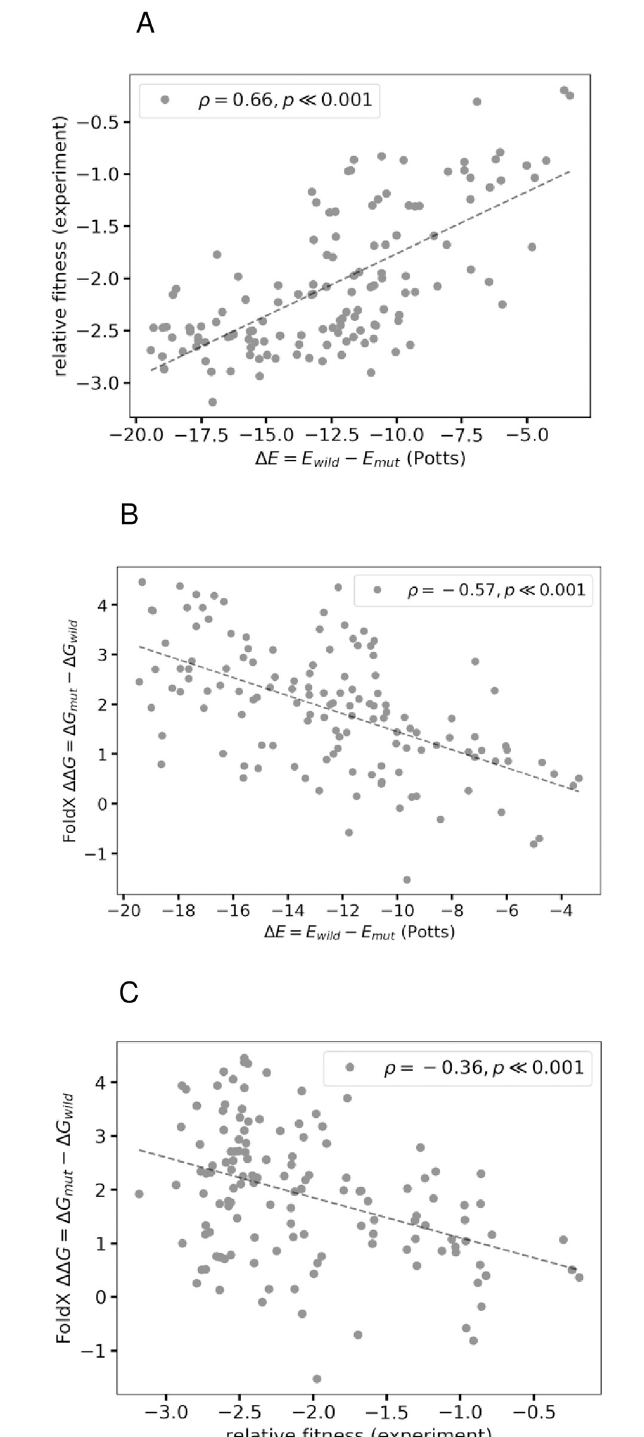
Fig 7. Potts model captures different features of the fitness landscape. Figure shows that the Potts model predicted Δ E s can capture different features of the fitness landscape that may be orthogonal, and may not correlate well with each other. (A) Relative fitness (replicative capacity) measurements obtained from deep mutational scanning of HIV-1 variants [28] involving combinations (of three or lesser) of mutations in protease associated with resistance to (particularly second-generation) inhibitors in clinic, are compared to changes in Potts statistical energies, Δ Es with a